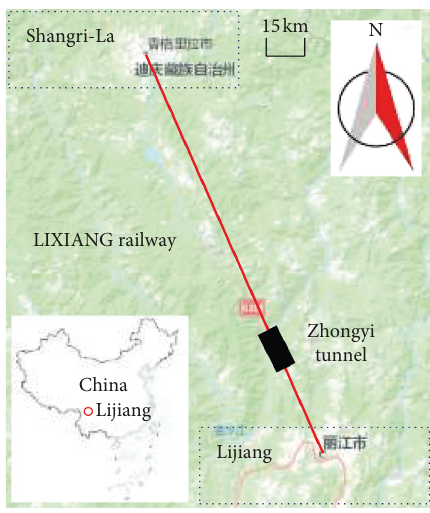
Figure 1: Lijiang to Shangri-La railway.